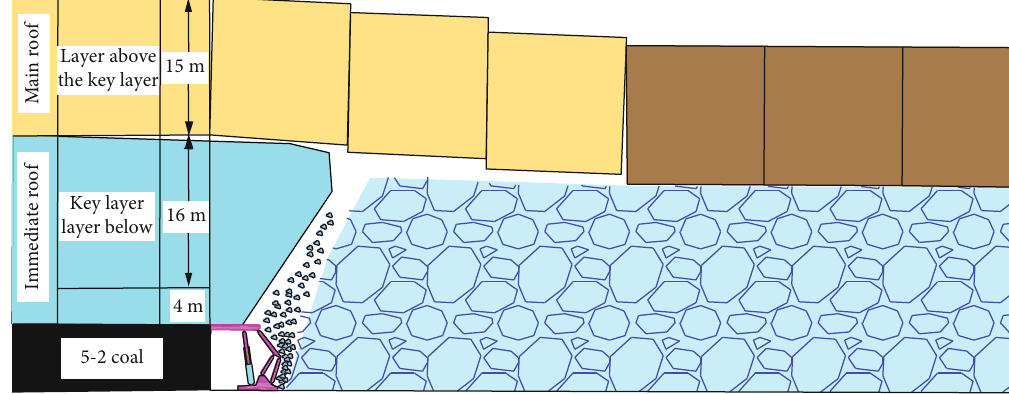
Figure 6: Model for structural mechanical analysis of quarry